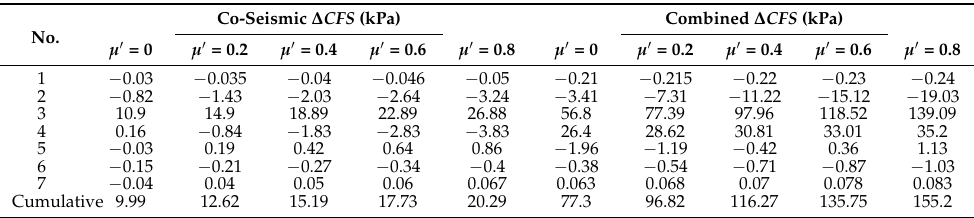
Table 3. Coulomb stress change ( ∆ CFS ) imparted by the historical earthquake with different effective friction coefficient ( µ (cid:48)